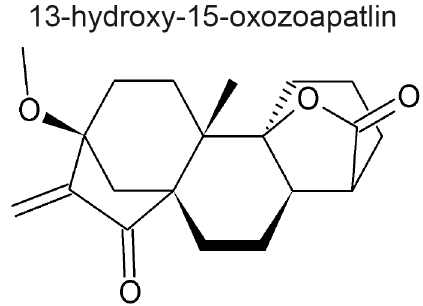
Figure 3. Structure of the ent -kaurane, 13-hydroxy-15-oxozoapatlin. This natural product has an α , β -unsaturated carbonyl, and an anti-mitotic activity similar to some of the sesquiterpene lactones reviewed here.